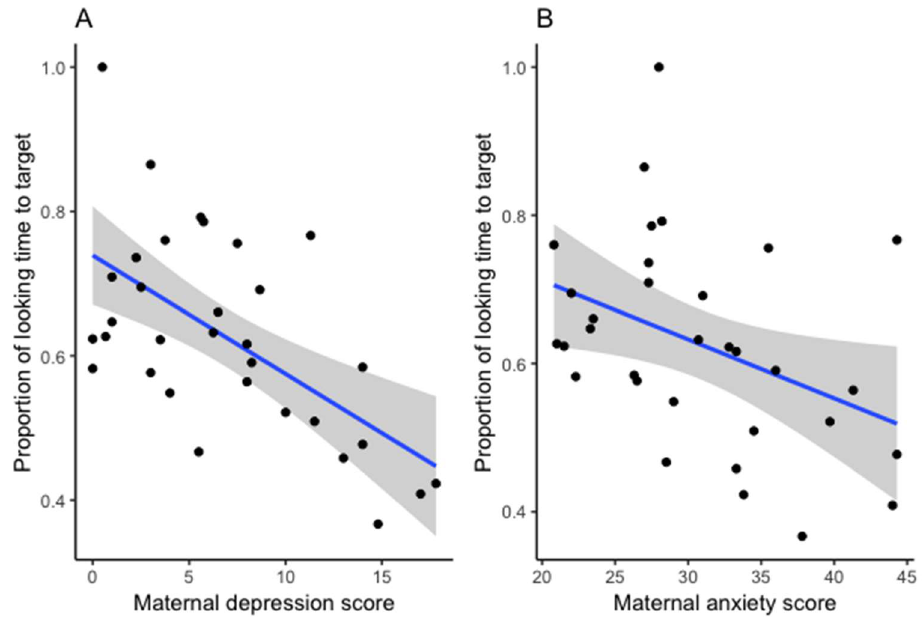
Figure 4. Infants’ lexical processing accuracy scores in relation to maternal depression ( A ) and anxiety ( B ) (the lines illustrate the linear model results and shaded areas represent the standard error of the mean).